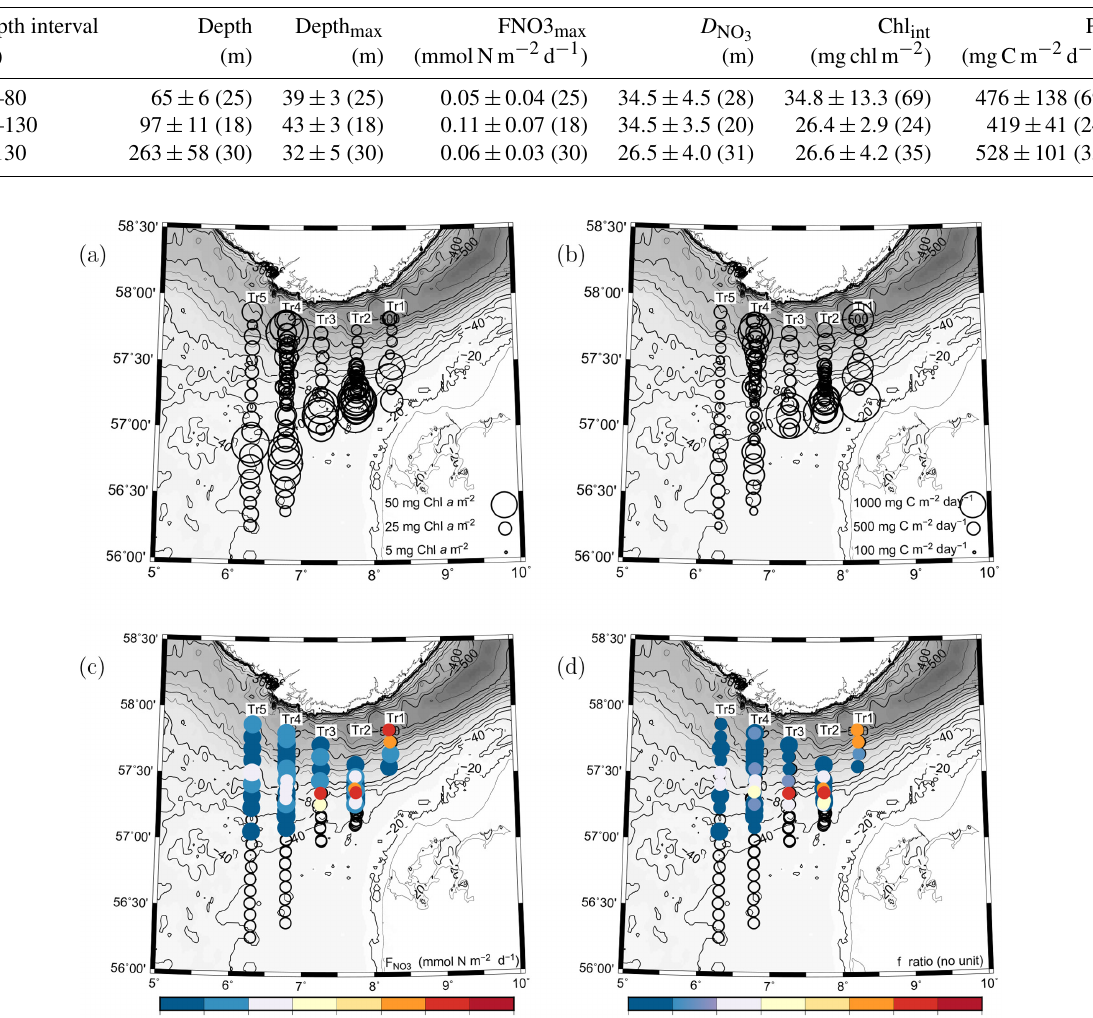
Figure 7. (a) Vertically integrated chlorophyll a (mgchl a m − 2 ) and (b) primary production (mgCm − 2 d − 1 ). Values are proportional to the diameter of the circles. (c) Distribution of maximum nitrate flux to the euphotic zone ( F NO euphotic zone (colours, no